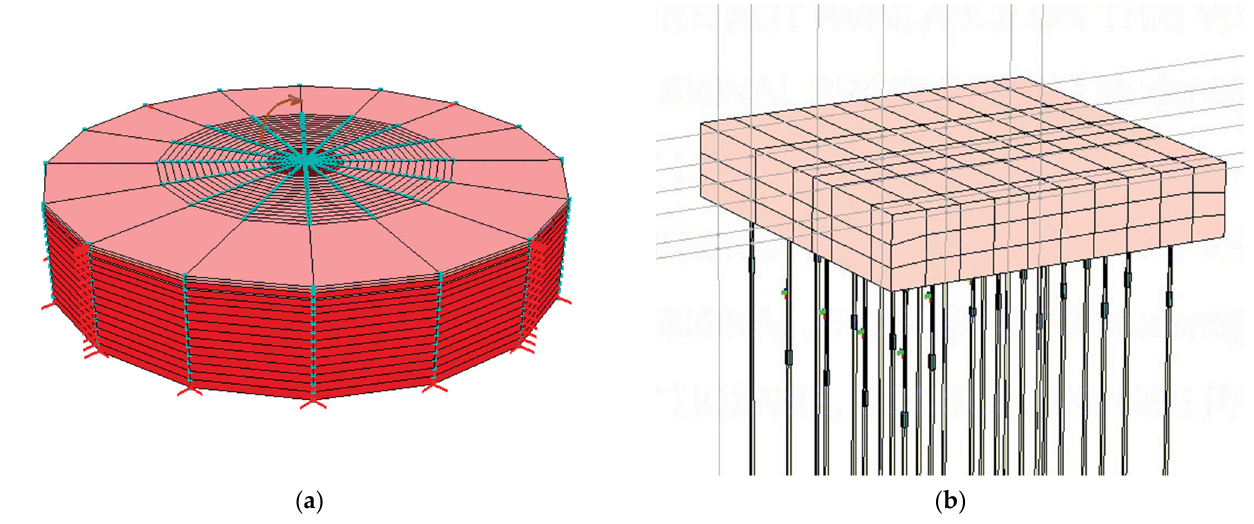
Figure 9. Foundation’s model of the PV-supporting structure in the Z-Soil program [77,117]: ( a ) a circular footing; ( b ) TITAN micropiles with a pile cap.